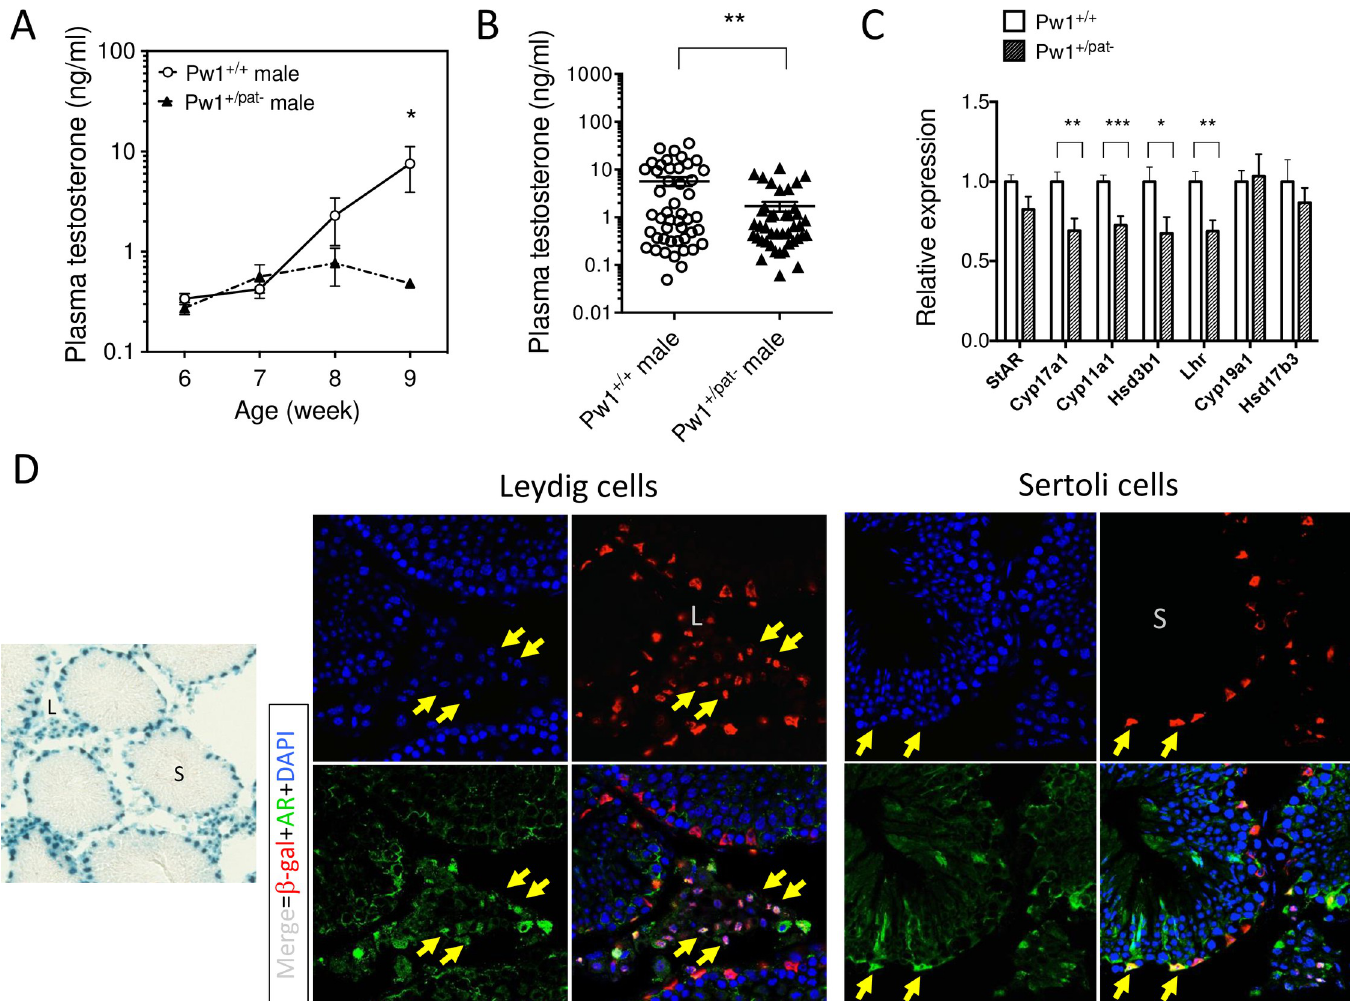
Fig 4. Reduced testosterone production in the Pw1 +/pat- males. ( A ) Plasma testosterone measurements at peripubertal age in Pw1 +/+ and Pw1 +/pat- males (n = 7 and 5, respectively, from 3 litters). Two-way repeated measures ANOVA with Sidak’s multiple comparisons test revealed a significant difference between genotypes at 9 weeks of age ( � P < 0.05). ( B ) Plasma testosterone levels in Pw1 +/+ and Pw1 +/pat- non-breeder littermates (n = 47 and n = 42) at 2.5–3 months of age. Each symbol represents independent animals. Bars represent mean ± SEM; �� , P < 0.01, by Mann Whitney U test. ( C ) mRNA expression of steroidogenic genes in the 2.5–3 month-old testes of Pw1 +/+ and Pw1 +/pat- non-breeder littermates (n = 15 versus n = 11). StAR, Steroidogenic acute regulatory protein; Cyp17a1, cytochrome P-450 17a; Cyp11a1, cholesterol side-chain cleavage enzyme; Hsd3b1, 3-b-hydroxysteroid dehydrogenase; Lhr, luteinizing hormone receptor; Cyp19a1, aromatase enzyme; Hsd17b3, 17-b-hydroxysteroid dehydrogenase. ( D ) Pw1 reporter expression in the 2.5-month-old testis of Pw1 IRESnLacZ mice, showing X-gal staining (x100) and β -gal immunofluorescence (x400) in the interstitial compartment and in the epithelium of seminiferous tubules. The β -gal immunofluorescence overlapped with that of androgen receptor (AR) in the Leydig and Sertoli cells (arrows). L, interstitial Leydig cells; S, seminiferous tubule. testosterone producing Leydig cells in the interstitial compartment and in the supporting Ser- toli cells near the basement membrane of seminiferous tubules. We note that other imprinted genes are highly expressed in the Leidig cells and that a number of imprinted genes are simul- taneously deregulated in Leidig cells of human patients with idiopathic germ cell aplasia [62]. Taken together, our data demonstrate that male sex-hormone signaling during secondary sexual maturation is suppressed in Pw1 +/pat- male mice, concomitant with reduced gene expression for testosterone biosynthesis in the testis, which may account for the reduced mas- culinization in metabolism and social behavior during the postnatal development.